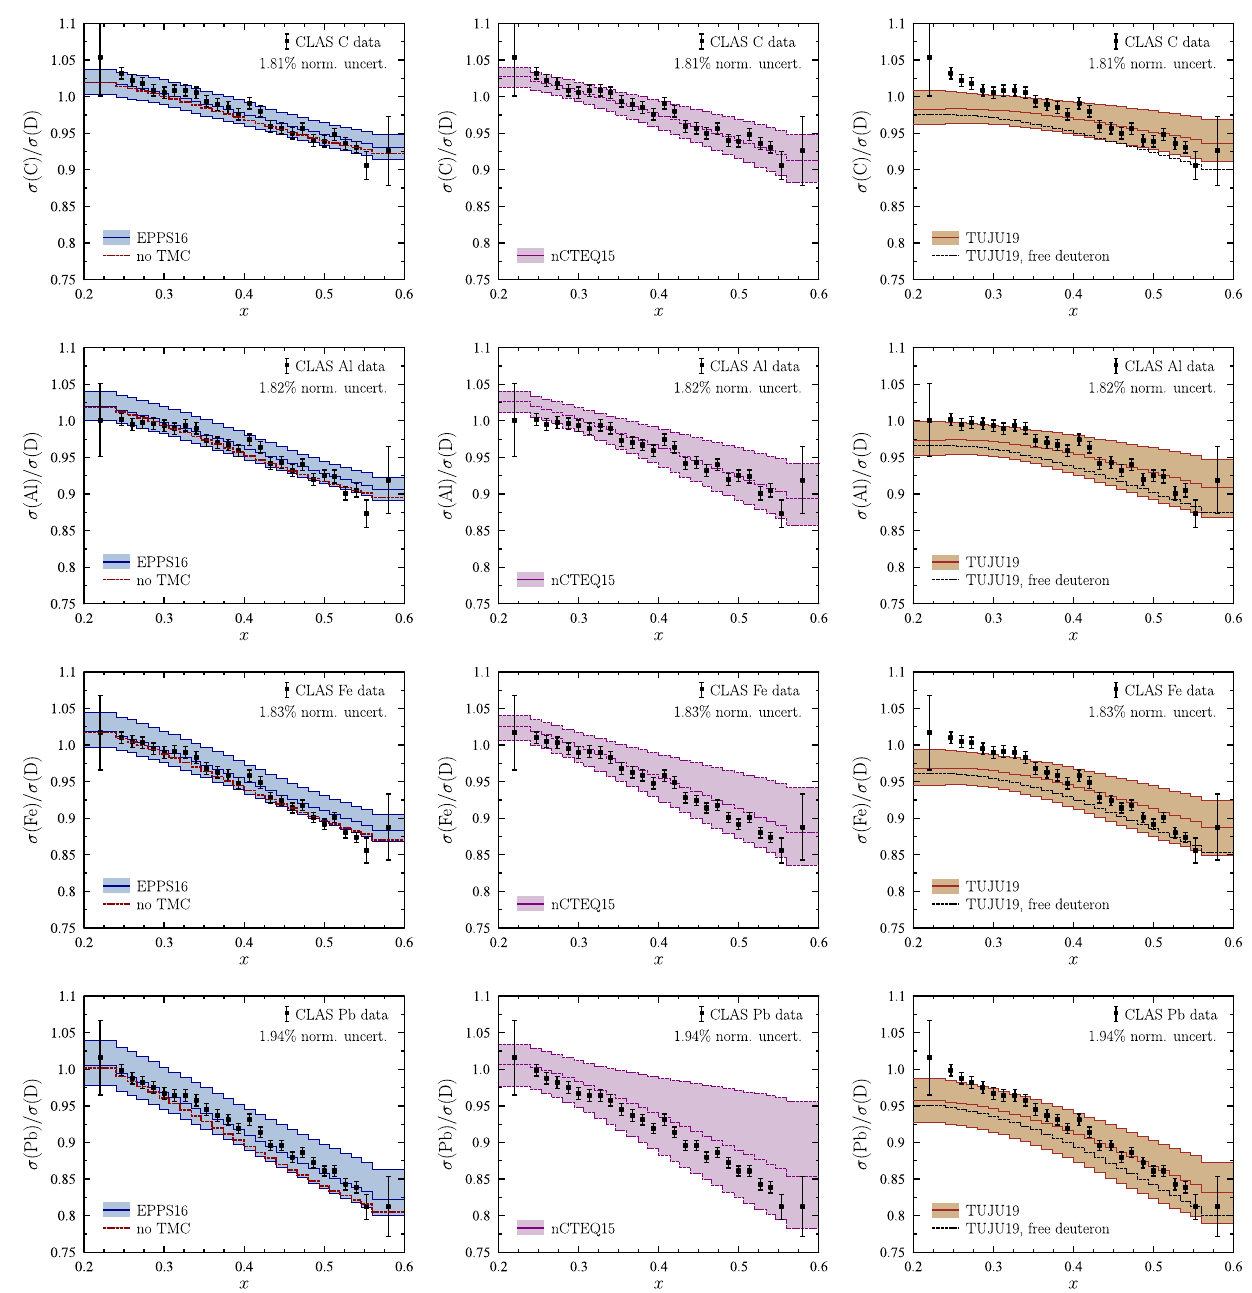
without (dashed line) nuclear effects in deuteron. The normalization uncertainties are not included in the data error bars